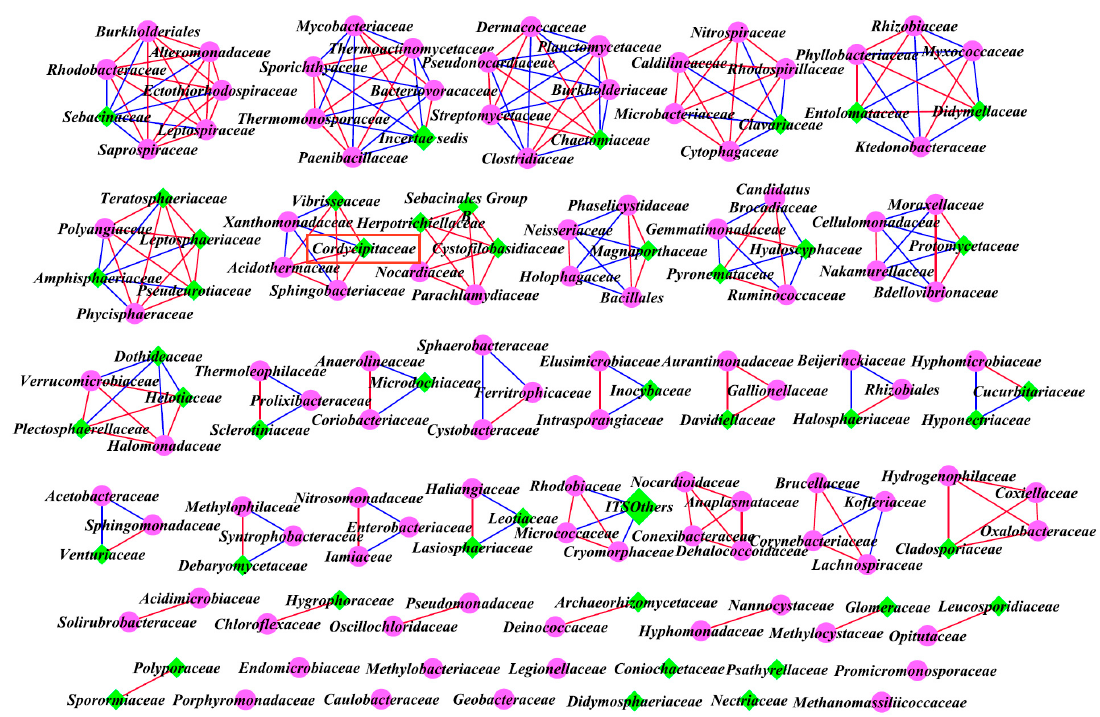
Figure 11. Inter-kingdom network of differentially abundant fungal and bacterial families at site C.Highly significant positive ( R > 0.80, FDR < 0.05) and negative ( R < − 0.80, FDR < 0.05) Pearson correlations are represented by red and blue lines. The size of each node is proportional to the degree. Fuchsia circles: bacterial kingdoms, green diamonds: fungal kingdoms, red rectangle highlights Cordyceps -related family.